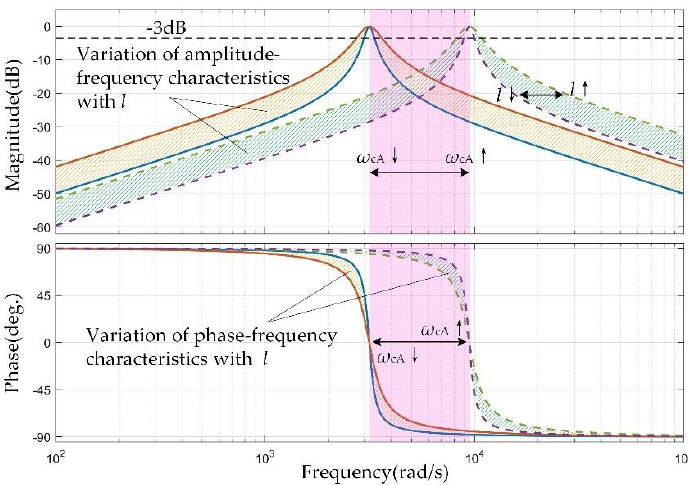
Figure 9. Bode of D A (s) when the center frequency changes. Once the current passes through the ASOGI, the PLL can be used for phase locking. The structure of the composed ASOGI-PLL rotor position observer is shown in Figure 10.